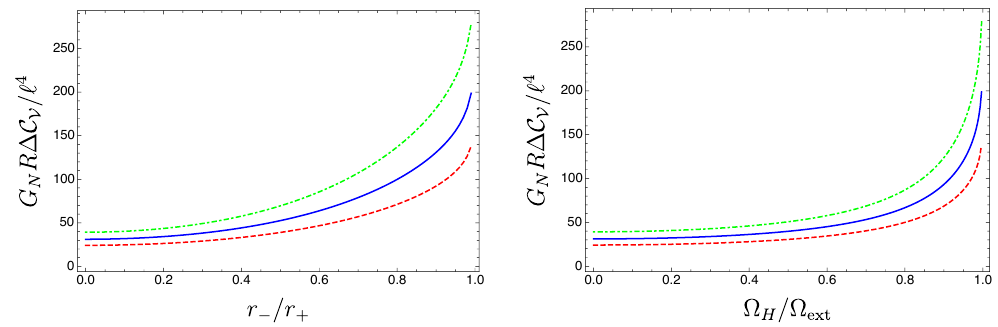
Figure 8. Here we show the complexity of formation within the CV proposal. Left : the curves correspond to r + /‘ = 9 / 10 , 1 , 11 / 10 from bottom to top for D = 5 . The complexity of formation diverges in the extremal limit and tends to a constant ( r + /‘ -dependent) value as r − /r + → 0 . Right : the same curves now plotted against the rotation of the boundary CFT in the form of the ratio Ω H / Ω ext where Ω H is the angular velocity of the boundary CFT and Ω ext is the zero temperature limit of this angular